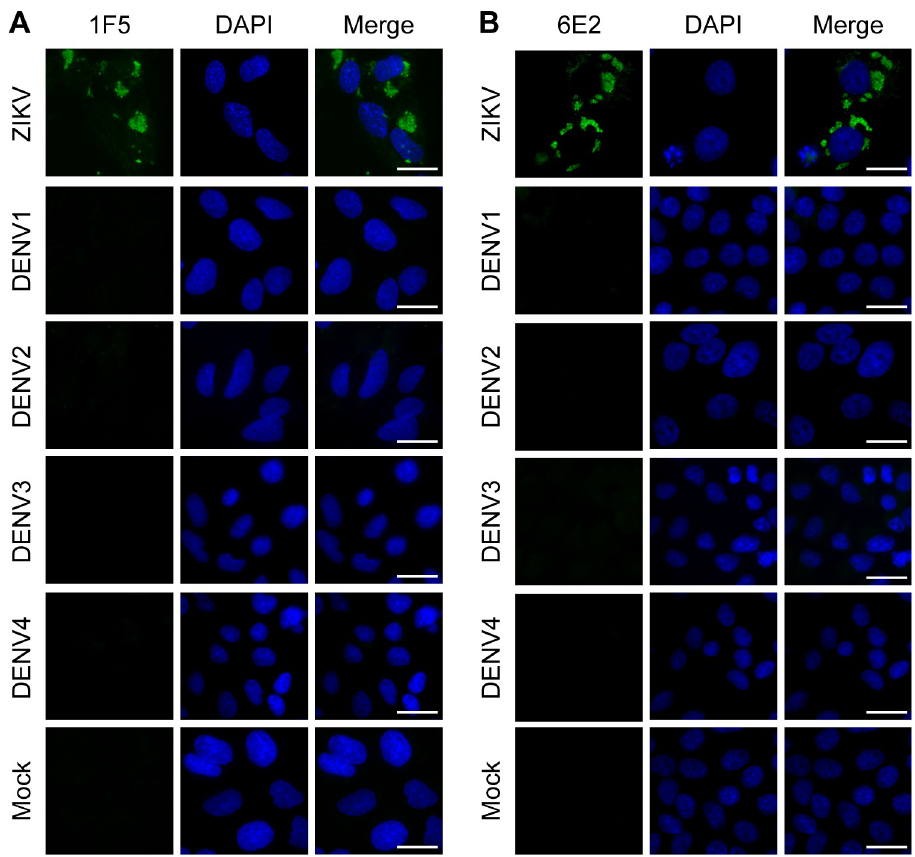
Fig 4. Cross-reactivity analysis of 1F5 and 6E2 mAbs against different flaviviruses in infected cells. Immunostaining of ZIKV and DENV1-4 A549 infected cells with (A) 1F5 or (B) 6E2 mAbs. Uninfected A549 cells (mock) were used as the negative control. Scale bar, 25 μ